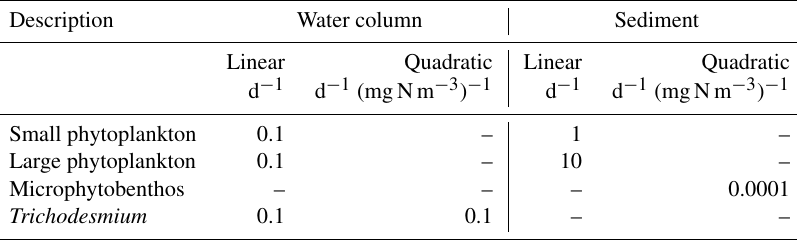
Table 15. Constants and parameter values used for plankton mortality.